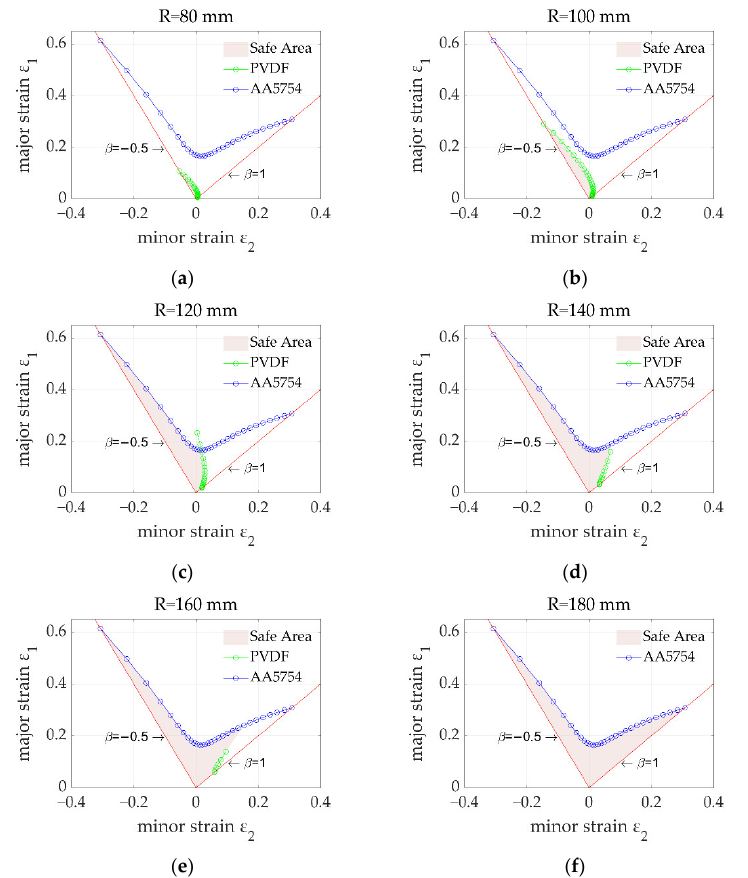
Figure 6. FLCs of PVDF and AA5754 with different punch radii: ( a ) 80 mm; ( b ) 100 mm; ( c ) 120 mm; ( d ) 140 mm; ( e ) 160 mm; ( f ) 180 mm.